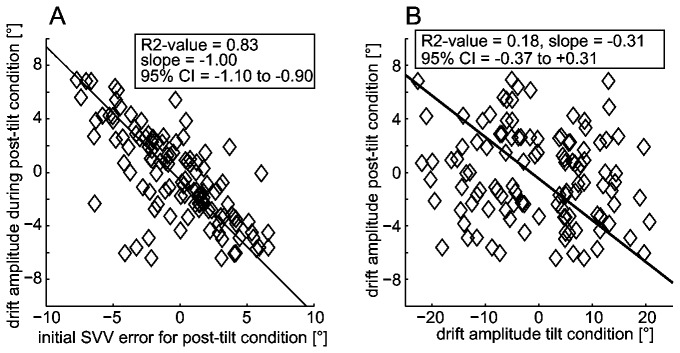
Characteristics of the post-tilt drift amplitude: correlation with initial offset and drift during prolonged roll-tilt.Panel A: Correlation analysis between the post-tilt drift amplitude and the initial post-tilt bias when returning to upright position using principal components analysis (PCA). The diamonds refer to single runs, the solid line indicates the fit obtained. In an inset, goodness of fit (R2-value), the slope and the 95% CI of the slope are provided. Panel B: Comparison of the individual drift amplitudes during prolonged roll-tilt and immediately after returning back upright using principal components analysis (PCA). The diamonds refer to single runs, the solid line indicates the fit obtained. In an inset, goodness of fit (R2-value), the slope and the 95% CI of the slope are provided.